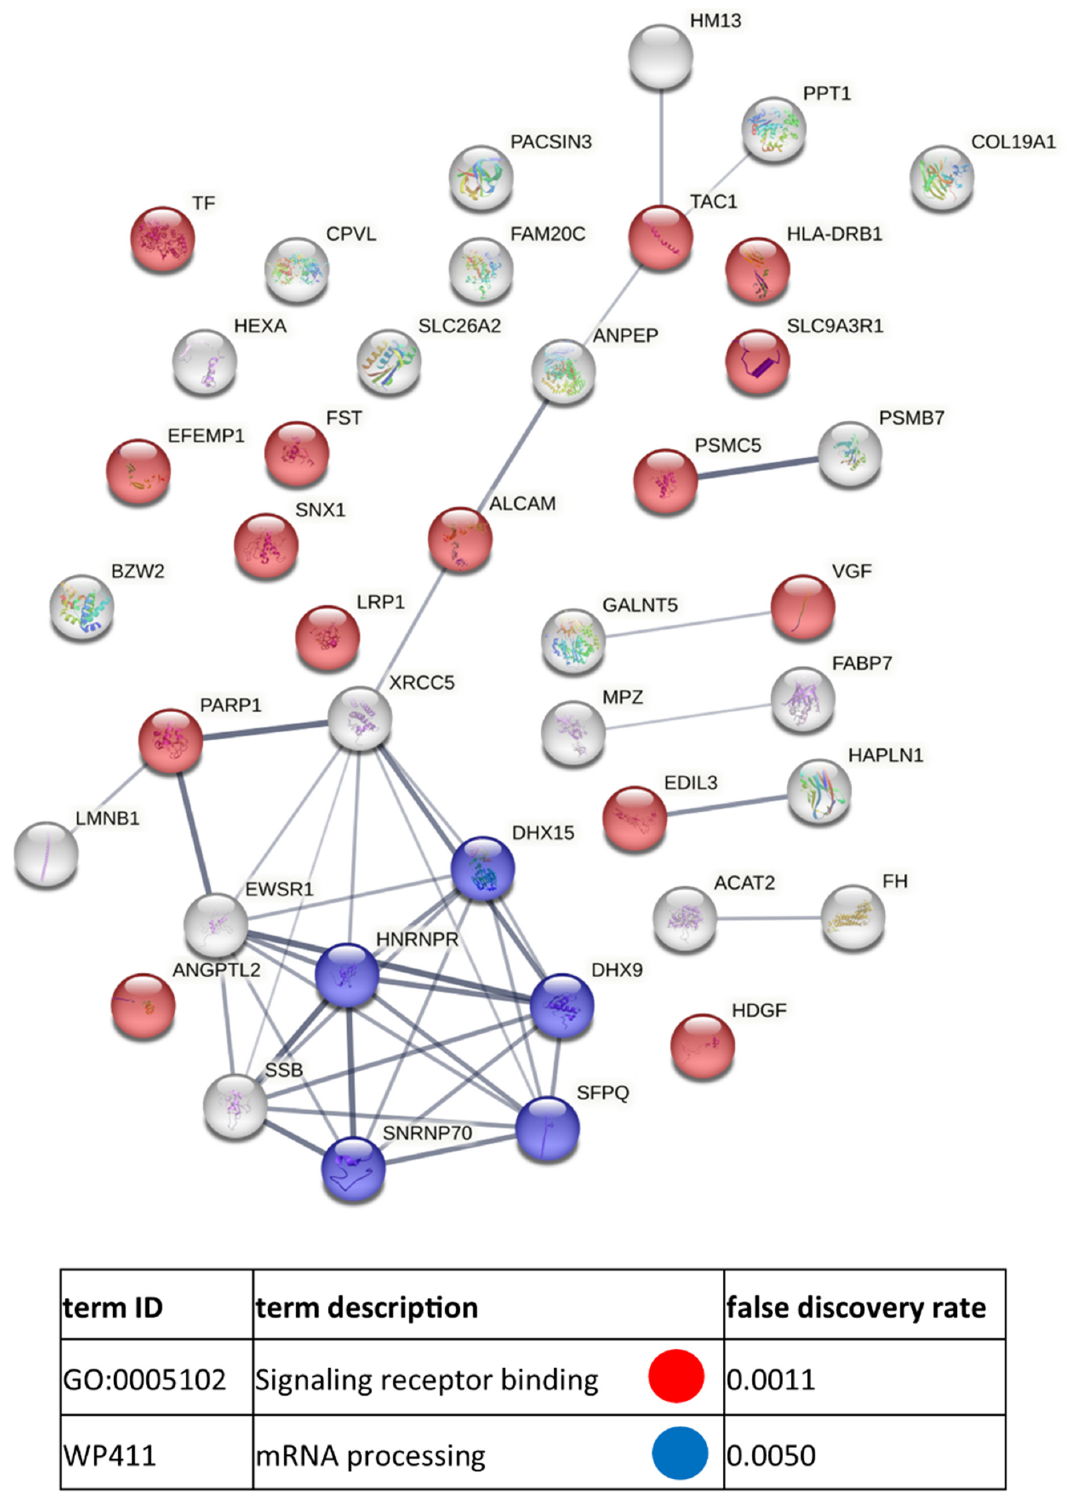
Figure A5. Diagram of functional protein association networks prepared with the use of STRING v. 11.0 software for proteins identified in WM793-derived exosomes cells but not found in any replicates of WM1205Lu exosomes. The selected, strongly represented pathways are presented as an interactome. A complete analysis is presented in Supplementary Data S3.